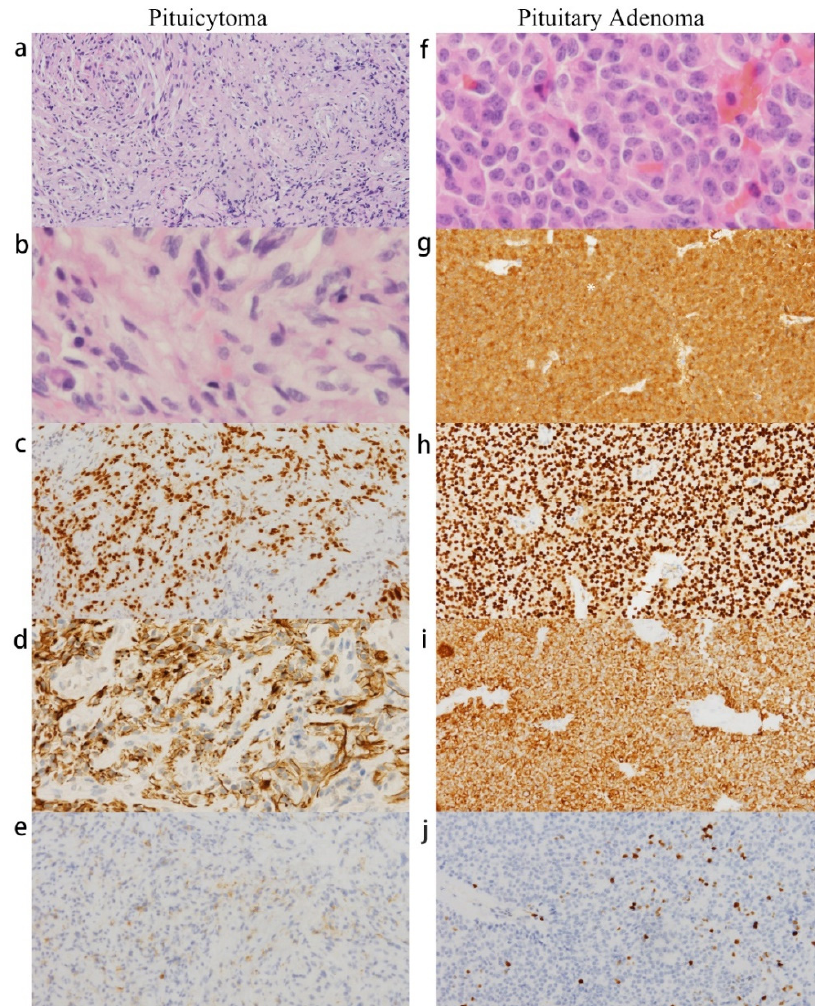
Figure 2. Comorbidity of pituicytoma and pituitary adenoma in case 1: ( a – e ) pituicytoma: ( a , b ) he- matoxylin-and-eosin (H&E) staining shows spindle cells in a mostly fascicular arrangement ( a , ×100; b , ×400); ( c – e ) TTF-1, GFAP, and EMA were positive in pituicytoma; ( f – j ) pituitary adenoma: ( f ) ( j ) increased ki-67 proliferative activity in adenoma